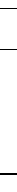
Table 1. Finalised test rig parameters.